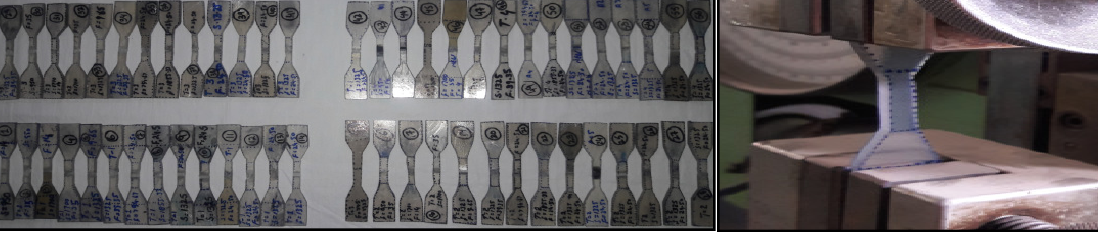
Fig. 7: Tensile Testing Specimens Fig. 8: Apparatus Setup of the Tensile Table 4: Response (Ultimate Tensile Strength (UTS))